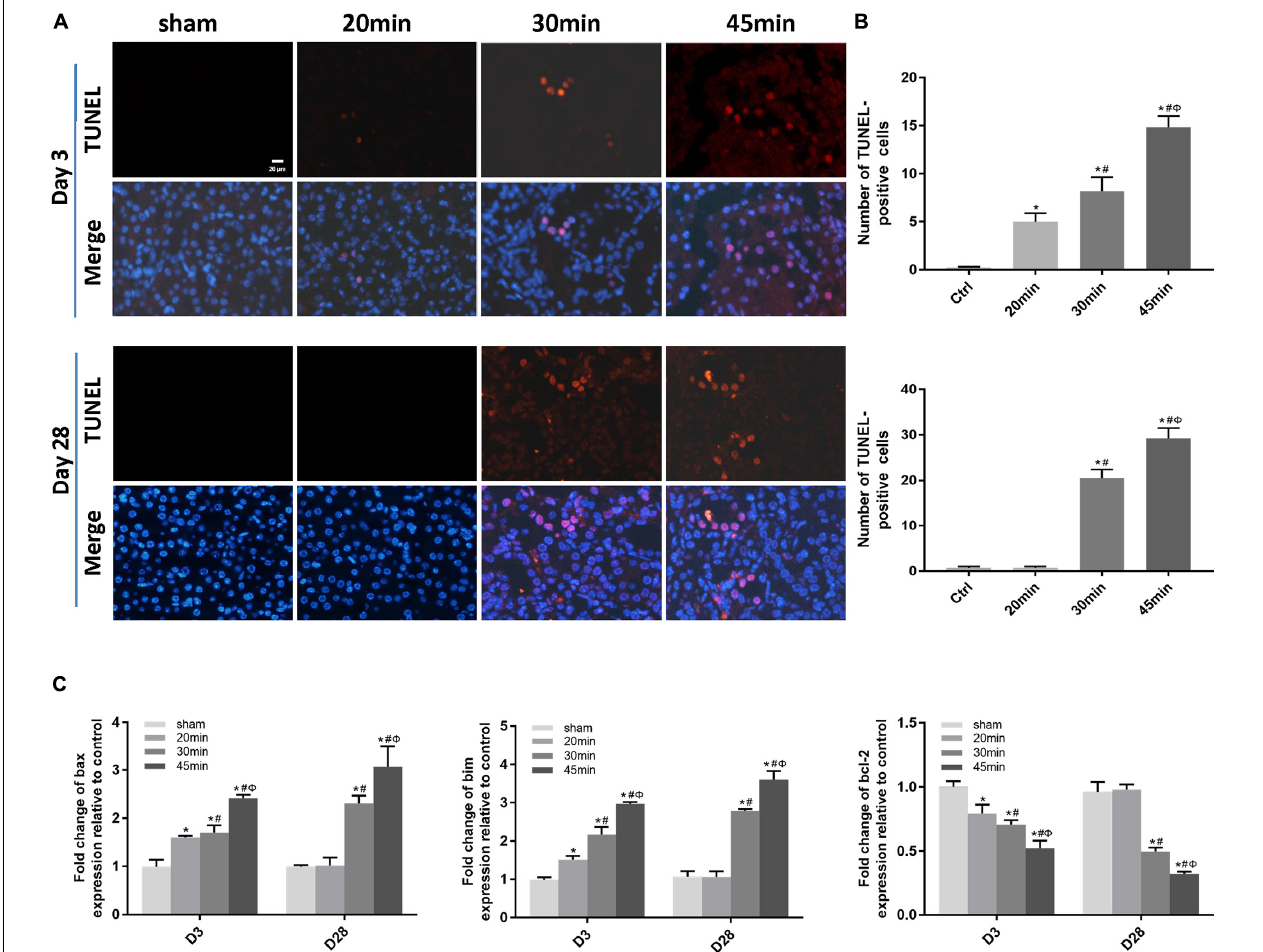
FIGURE 4 | Elevated apoptosis was associated with IRI-induced AKI severity and the AKI-to-CKD progression. (A) TUNEL staining to measure the apoptosis of renal tubular epithelial cells in each mouse group at days 3 and 28 post ischemia (original magnification × 400; Scale bar, 20 µ m). (B) Quantitative analysis of the number of apoptotic cells in each group. (C) Expression of proapoptotic genes (Bax and Bim) and the antiapoptotic gene bcl-2 was measured by real-time PCR. Data are presented as the means ± SEM of four experiments. n = 6; ∗ P < 0.05 vs. the control group. # P < 0.05 vs. the 20-min ischemia group. (cid:56) P < 0.05 vs. the 30 min-ischemia